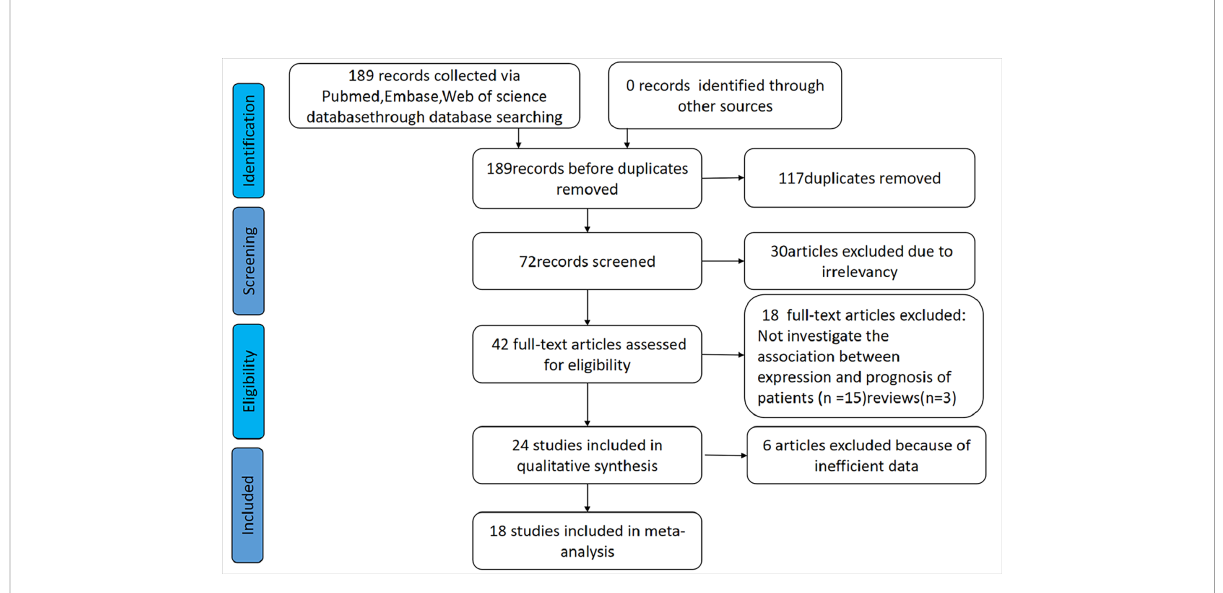
FIGURE 1 The fl ow diagram of the eligible